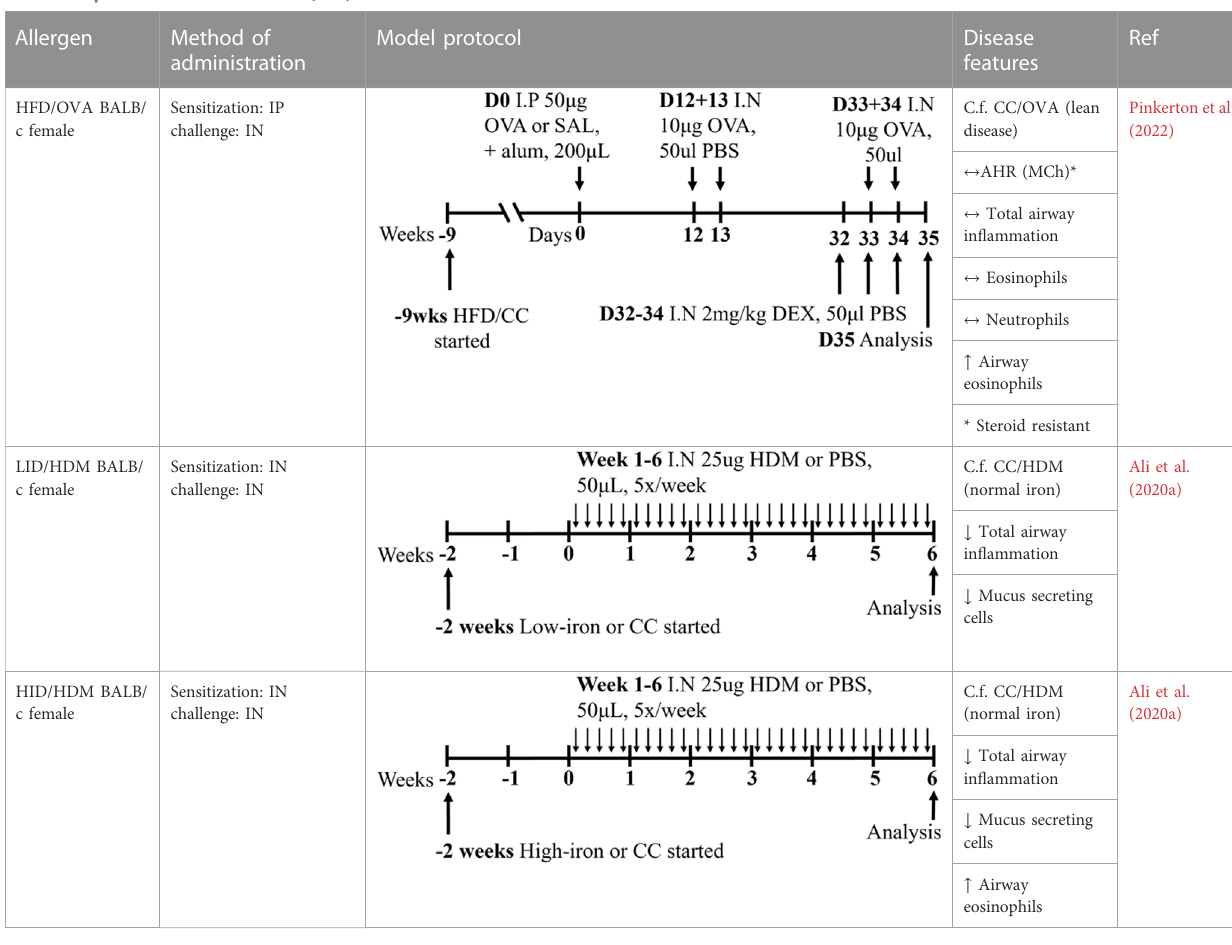
TABLE 3 Experimental asthma models